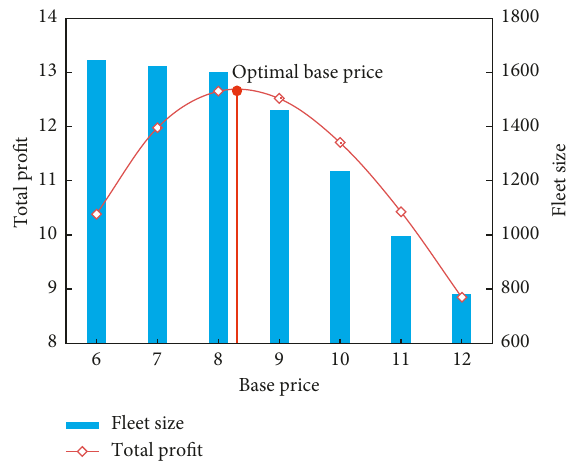
Figure 16: The optimal base price for the Sioux Falls